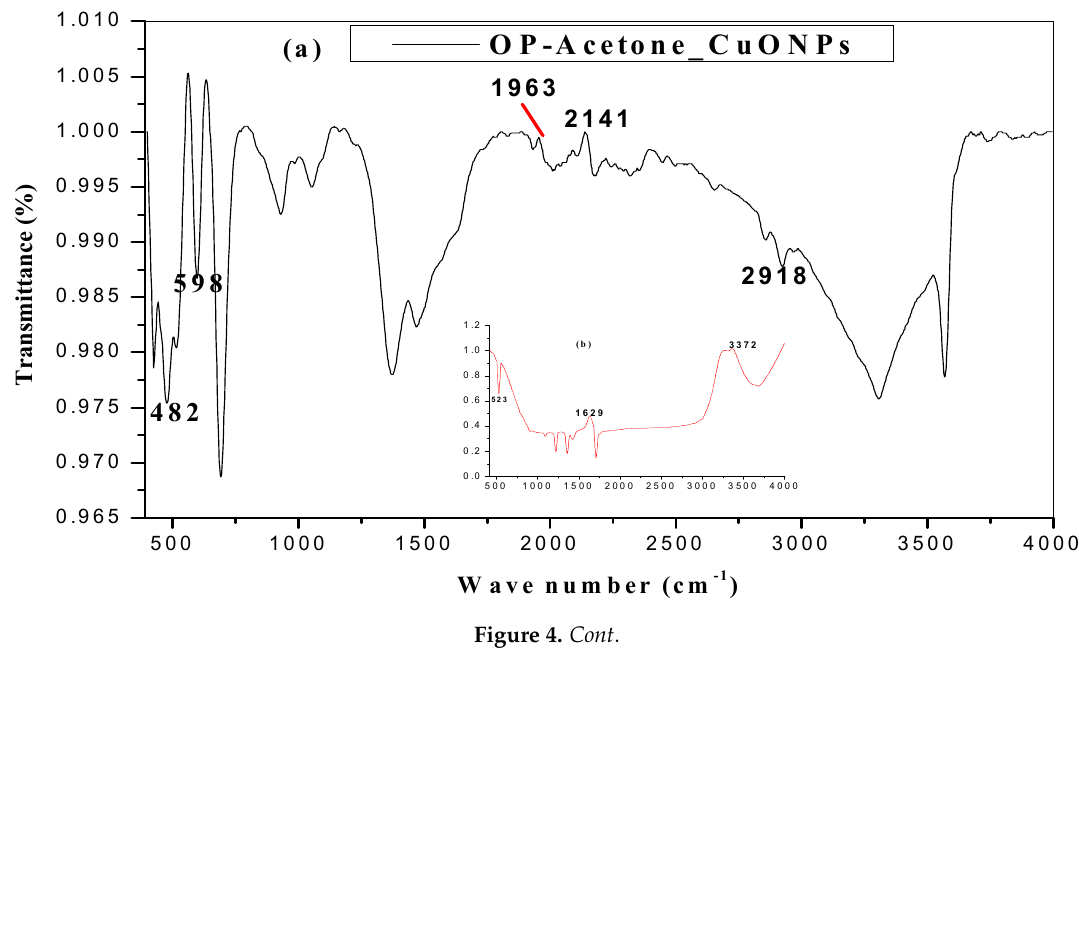
Figure 3. The FTIR spectra of CuONPs from ( a ) orange ( b ) tangerine and ( c ) lemon peel extracts in distilled water; insert is the spectra for the respective citrus extracts.